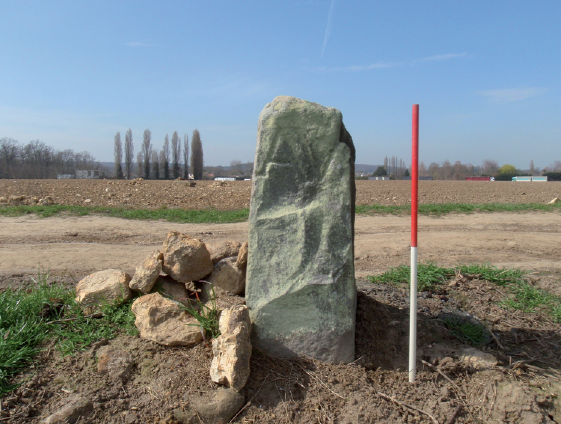
Figure 8. Parish limit marker between Avrainville (AV on the stone) and Boissy-sous-Saint-Yon along the Old Path at the suppo- sed location of a gallo-roman leaguestone. © J.